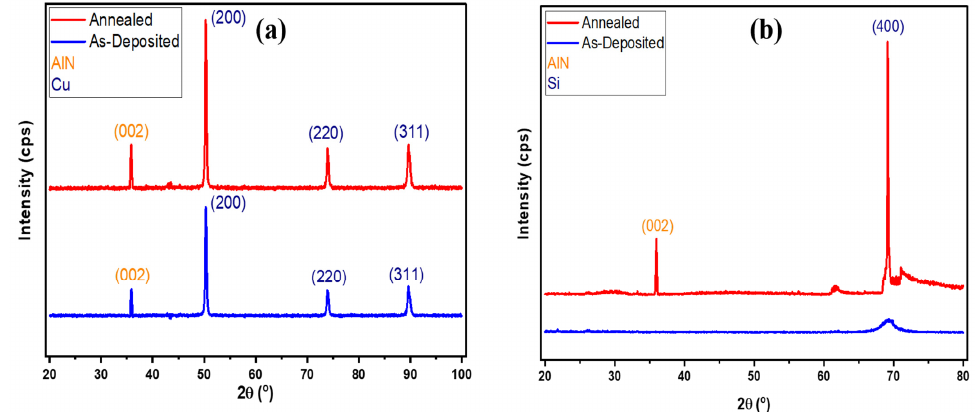
Figure 3. X-ray diffraction (XRD) patterns of the deposited Ni-doped AlN thin film with indexed lattice planes ( a ) Copper substrate and ( b ) Silicon substrate.